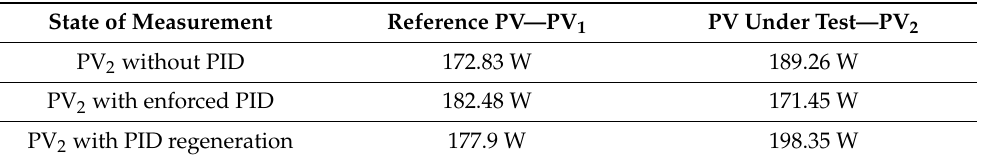
Table 4. Experimental Maximum Power Point (MPP) for the reference PV (PV 1 ) and for the PV under test (PV 2 ) before and after PID occurrence and with PID